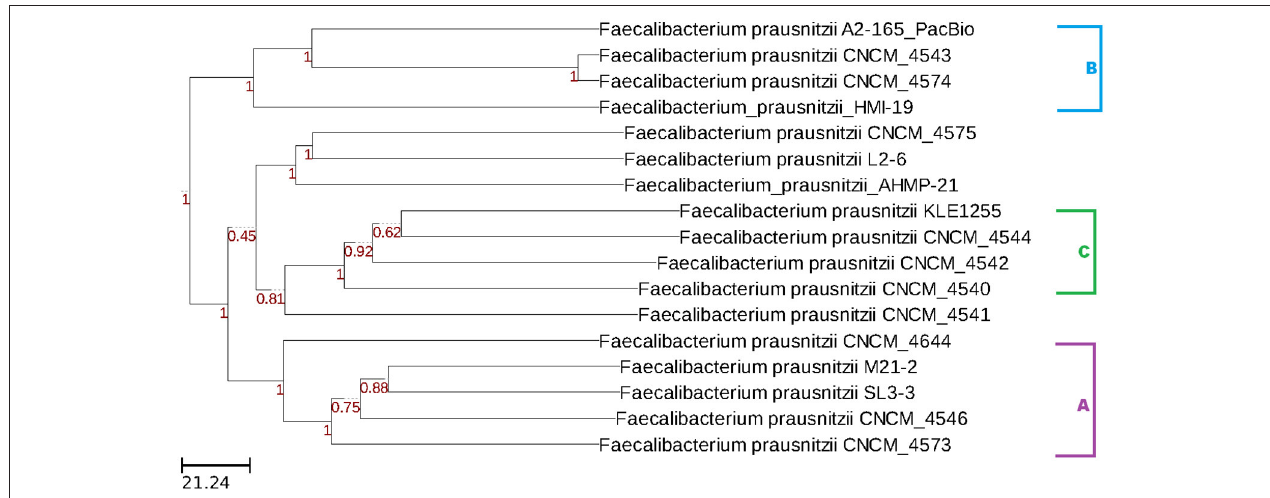
FIGURE 3 | Dendrogram constructed with wgMLST profiles for 17 F. prausnitzii genomes. The PGAdb profile from the genomes was used to construct a wgMLST tree using the Build_wgMLSTtree module (Liu et al., 2016). Bootstrap values are shown next to the nodes. The dendrogram was constructed with the UPGMA clustering